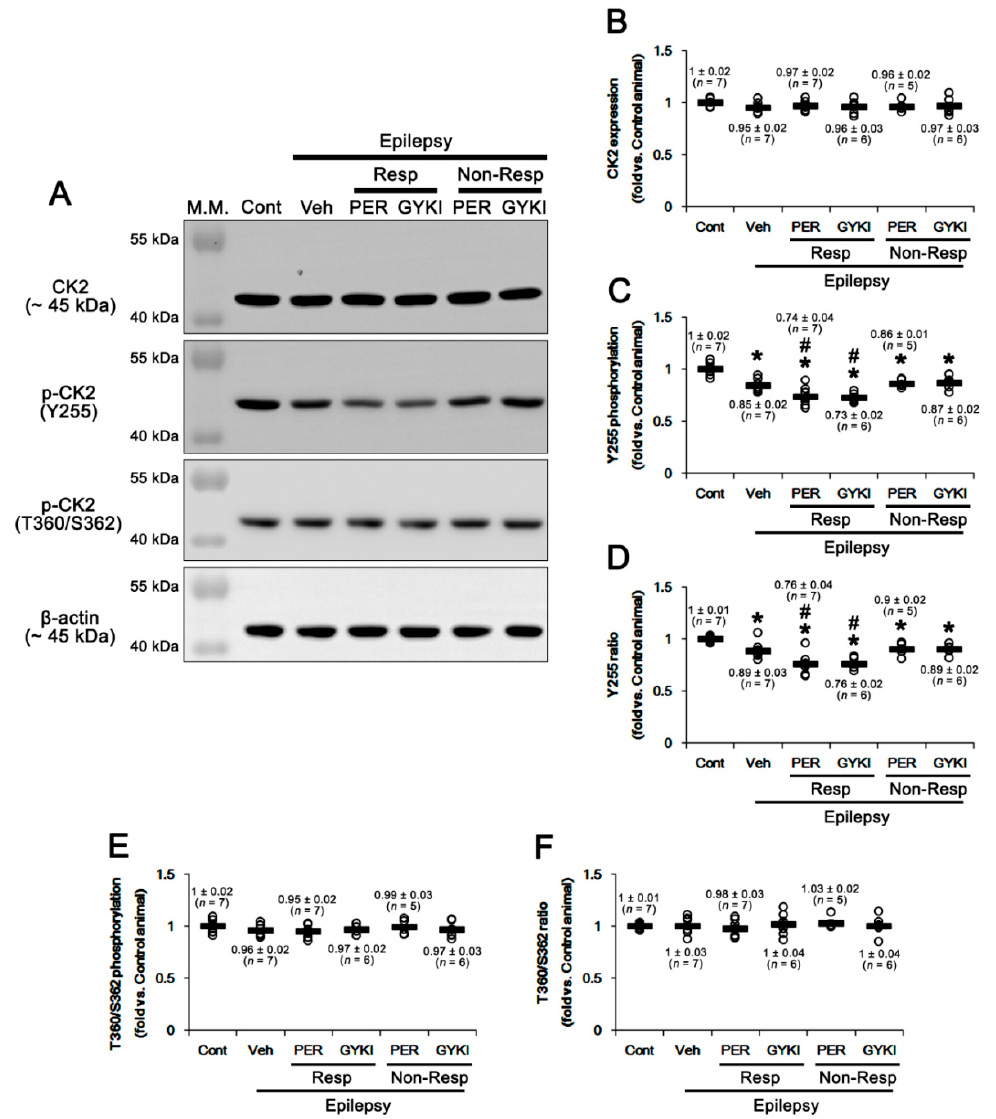
Figure 4. The e ff ects of perampanel (PER) and GYKI 52,466 (GYKI) on total casein kinase 2 (CK2) and its Y255 and T360 / S362 phosphorylations in chronic epilepsy rats. Both AMPAR antagonists reduce only CK2 Y255 phosphorylation in responders (Resp), but not non-responders (Non-Resp). ( A ) Representative images for Western blot of CK2 and p-CK2 levels in the hippocampal tissues. ( B – F ) Quantifications of CK2 ( B ), p-CK2 Y255 ( C ), p-CK2 Y255 / CK2 ratio ( D ), p-CK2 T360 / S362 ( E ), and p-CK2 T360 / S362 / CK2 ratio ( F ) levels in the hippocampal tissues. Open circles indicate each individual value. Horizontal bars indicate mean value. Error bars indicate SEM ( * , # p < 0.05 vs. control and vehicle (Veh)-treated animals, respectively; one-way ANOVA with post hoc Bonferroni’s multiple comparison).